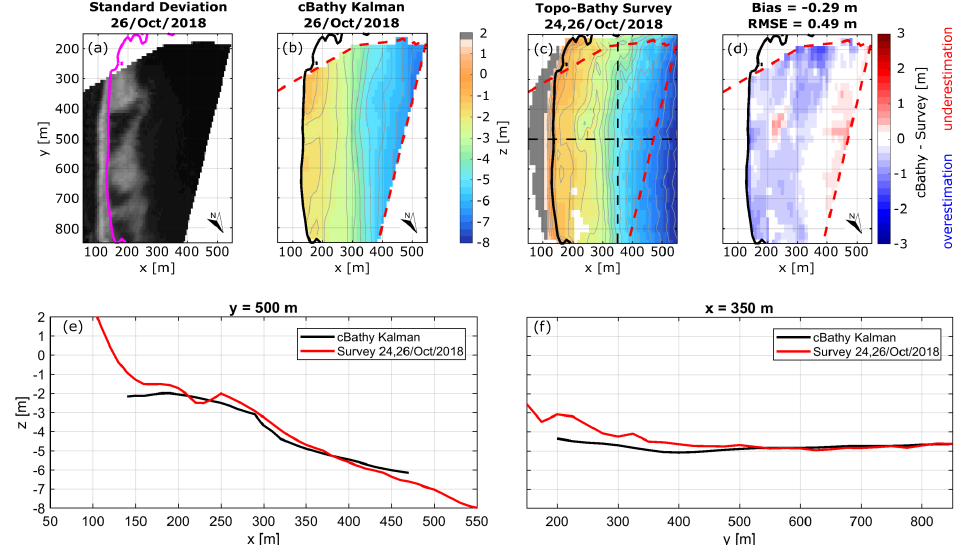
Figure 6. cBathy (26/Oct/2018) vs. interpolated topo- (24/Oct/2018) bathymetry (26/Oct/2018) survey. ( a ) Standard deviation image showing the amount of change in pixel intensity over the record length of the stack in order to highlight preferential wave breaking. The magenta line indicates the zero-elevation contour relative to NGF-IGN69. Elevation contours are spaced at 0.5 m intervals relative to NGF-IGN69. ( b ) Kalman-filtered cBathy -derived bathymetry, ( c ) surveyed topo-bathy and ( d ) difference between both, where red (blue) colors indicate depth underestimation (overestimation) in cBathy results. ( e ) Cross-shore and ( f ) alongshore transects, indicated by the black dashed lines in panel ( c ), showing the comparison between cBathy (black solid line) and the surveyed profile (red solid line). The red dashed lines indicate the limits of video-monitoring